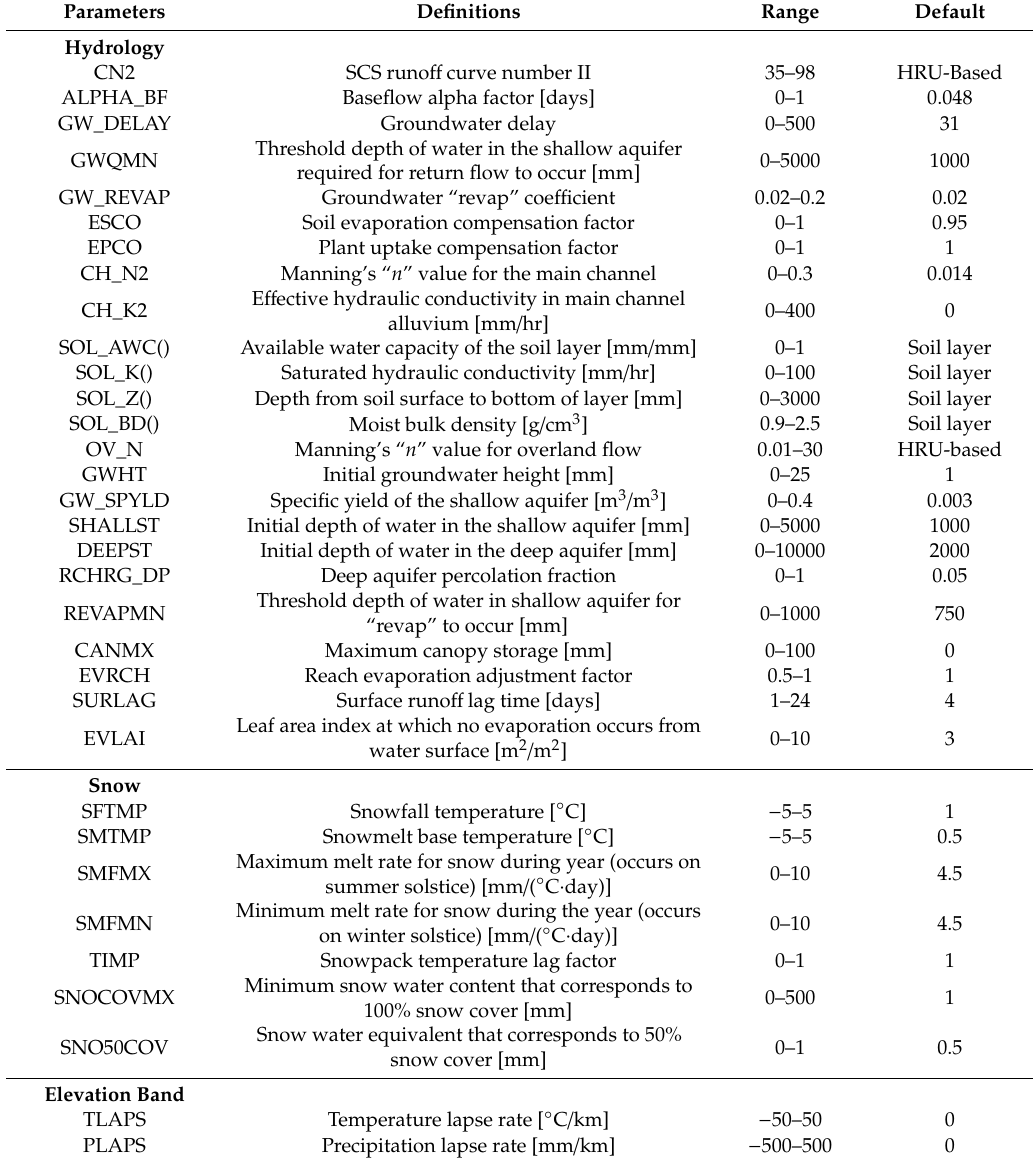
Table 1. Basic information for parameters considered in the Soil and Water Assessment Tool (SWAT)